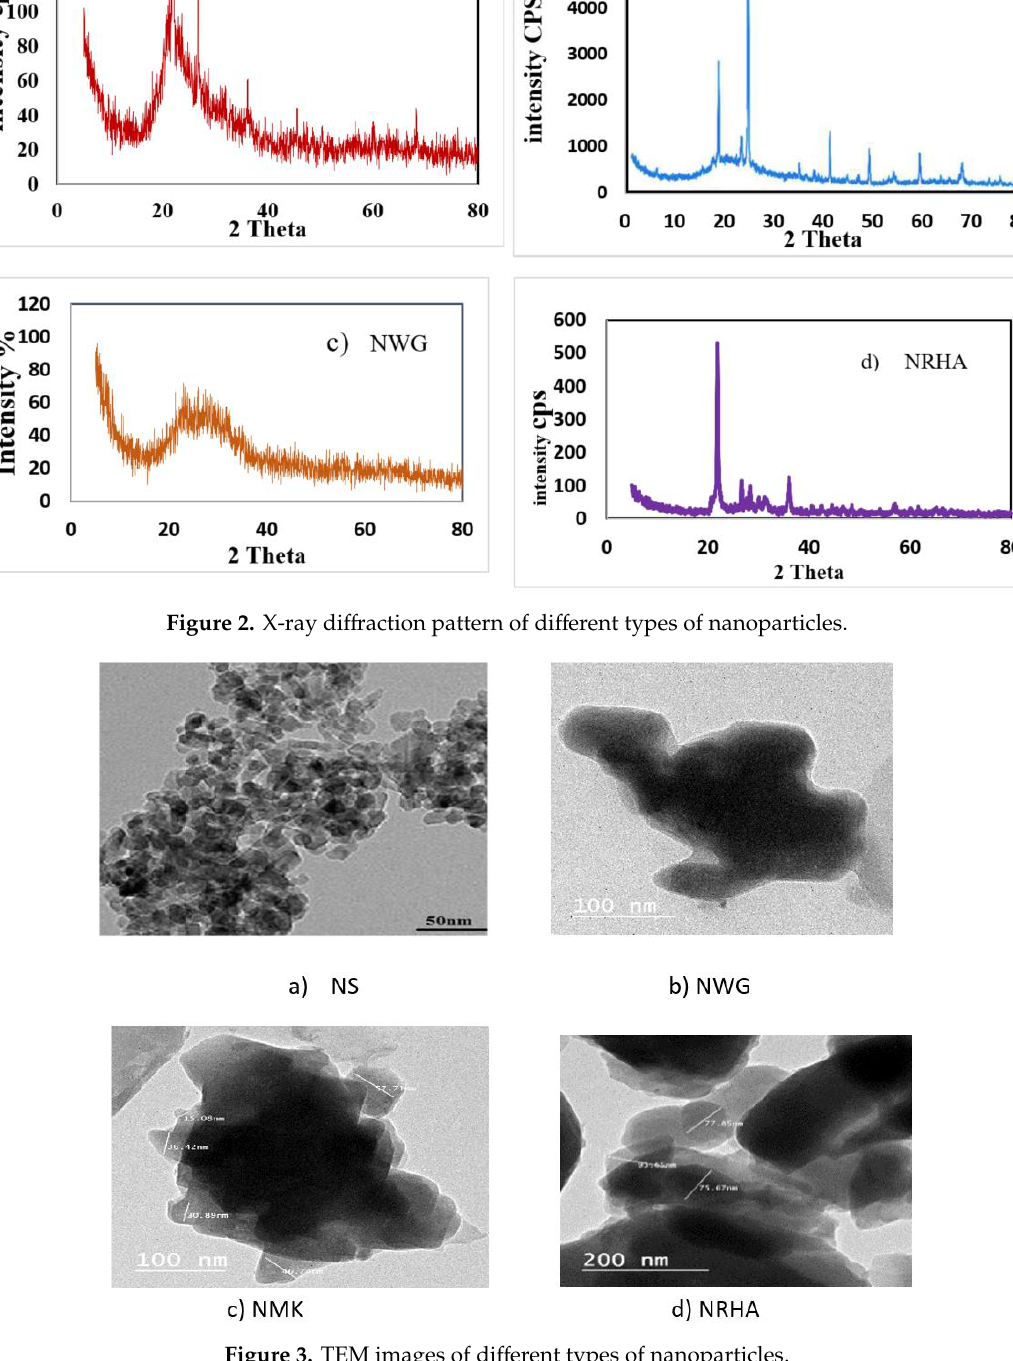
Figure 3. TEM images of different types of nanoparticles.